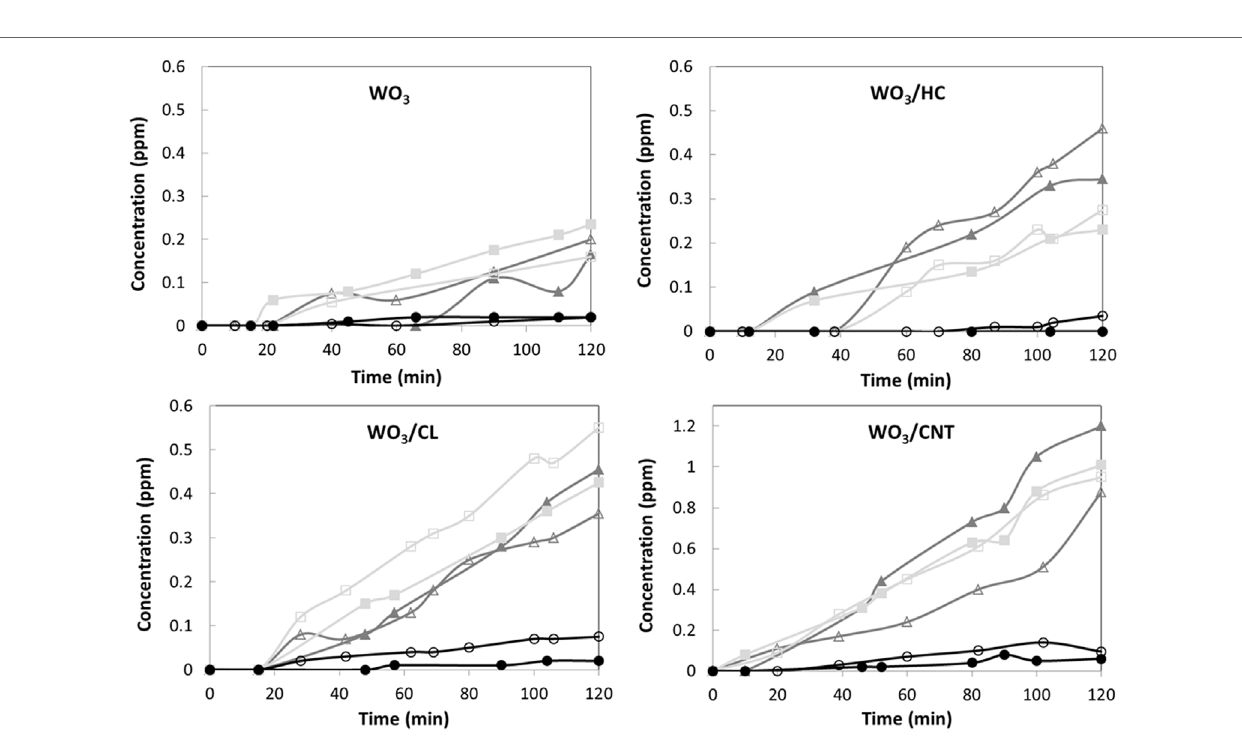
FigUre 4 | evolution of the phenol photooxidation intermediates detected in solution upon irradiation of the studied materials for a catalyst loading of 0.5 (open symbols) and 1 g/l (closed symbols): benzoquinone (circles), catechol (triangles), and hydroquinone (squares) . 50 mg L − 1 phenol in solution at the beginning of the